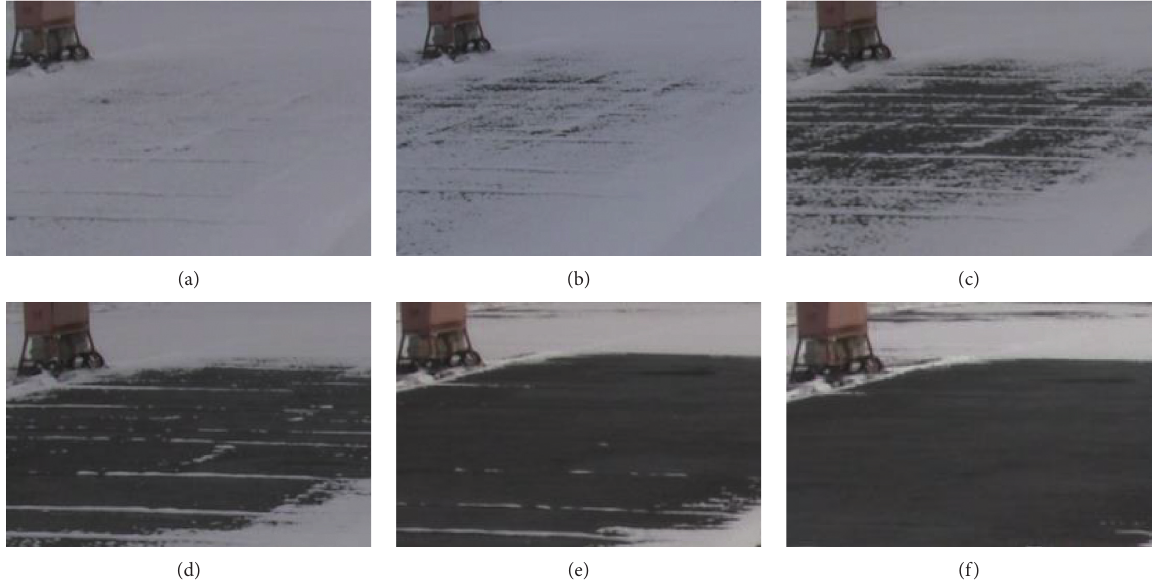
Figure 7: Melting snow on 1# asphalt pavement. (a) 60 minutes. (b) 80 minutes. (c) 90 minutes. (d) 100 minutes. (e) 110 minutes. (f) 120